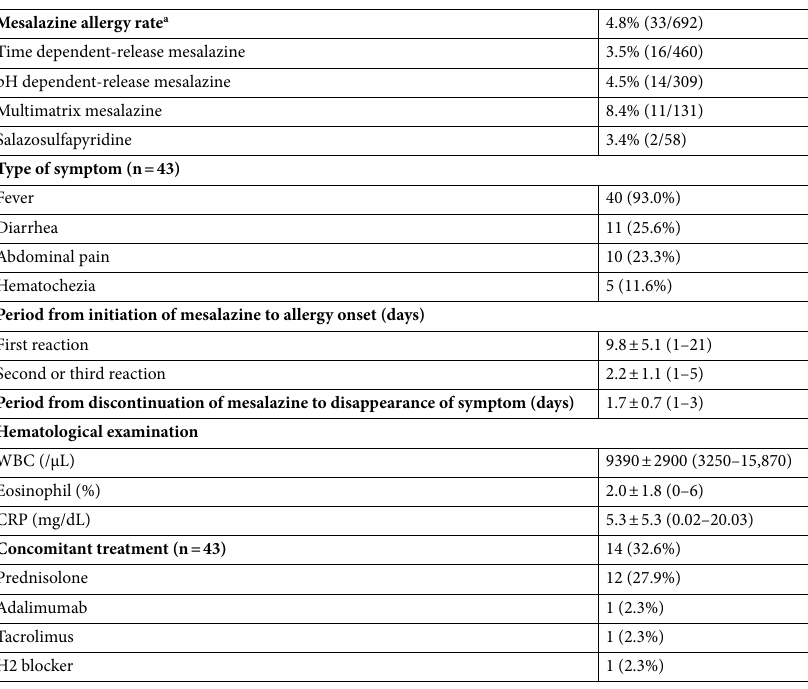
Table 3. Clinical course of 43 mesalazine allergy cases (n = 33). WBC white blood cell, CRP C-reactive protein. a The allergy incidence rate for each drug includes cases with a history of taking multiple types of mesalazine.